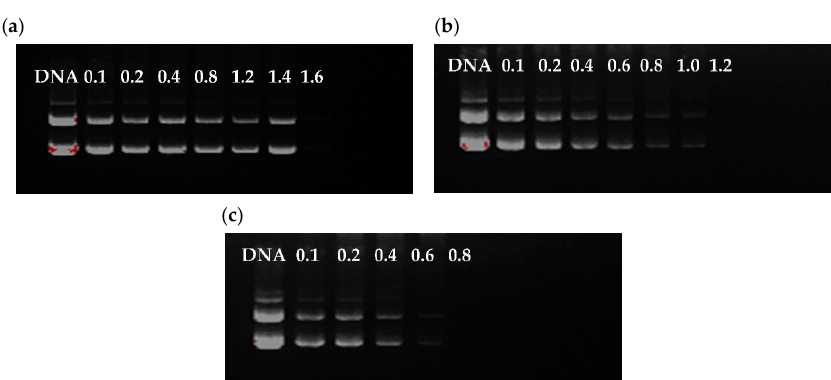
Figure 3. Agarose gel electrophoresis of plasmid DNA and ( a ) CUR-PEI-K14-1, ( b ) CUR-PEI-K14-3, and ( c ) CUR-PEI-K14-10 complexes at various w / w ratios.